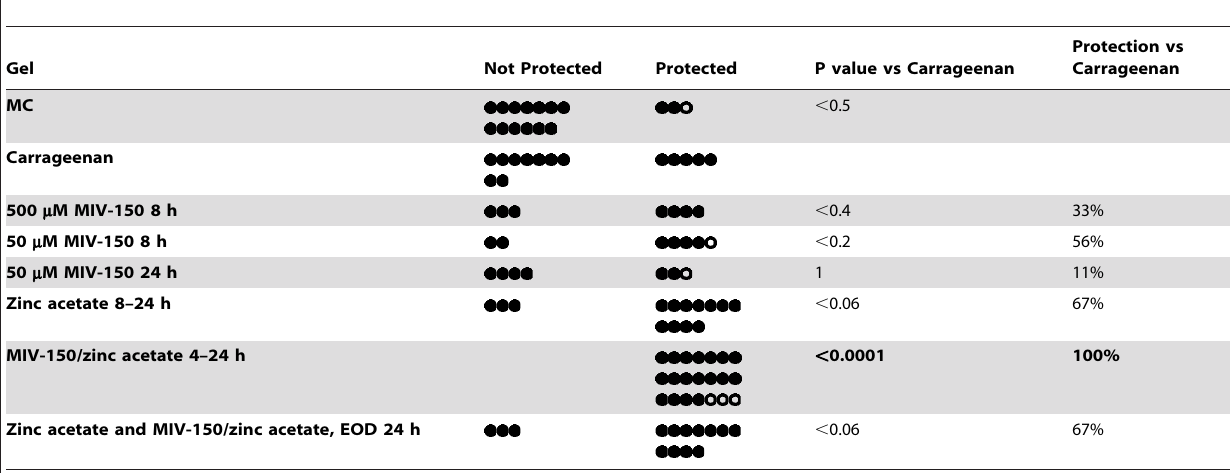
Gel Not Protected Protected P value vs